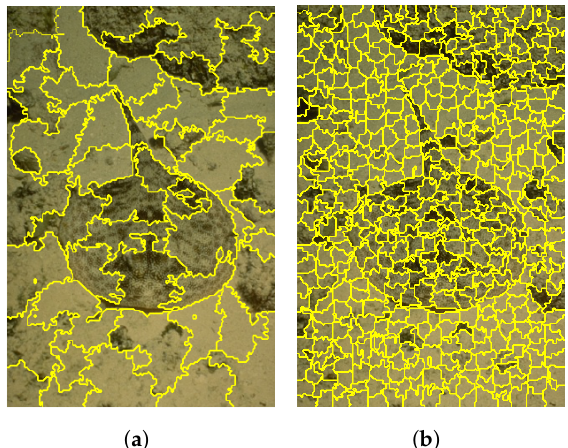
Figure 6. Comparison of segmentation effect with different superpixel numbers. ( a ) is the divided image when the number of super pixels k = 50, and ( b ) is the divided image when the number of super pixels k = 500. ( a ) k = 50. ( b ) k = 500.